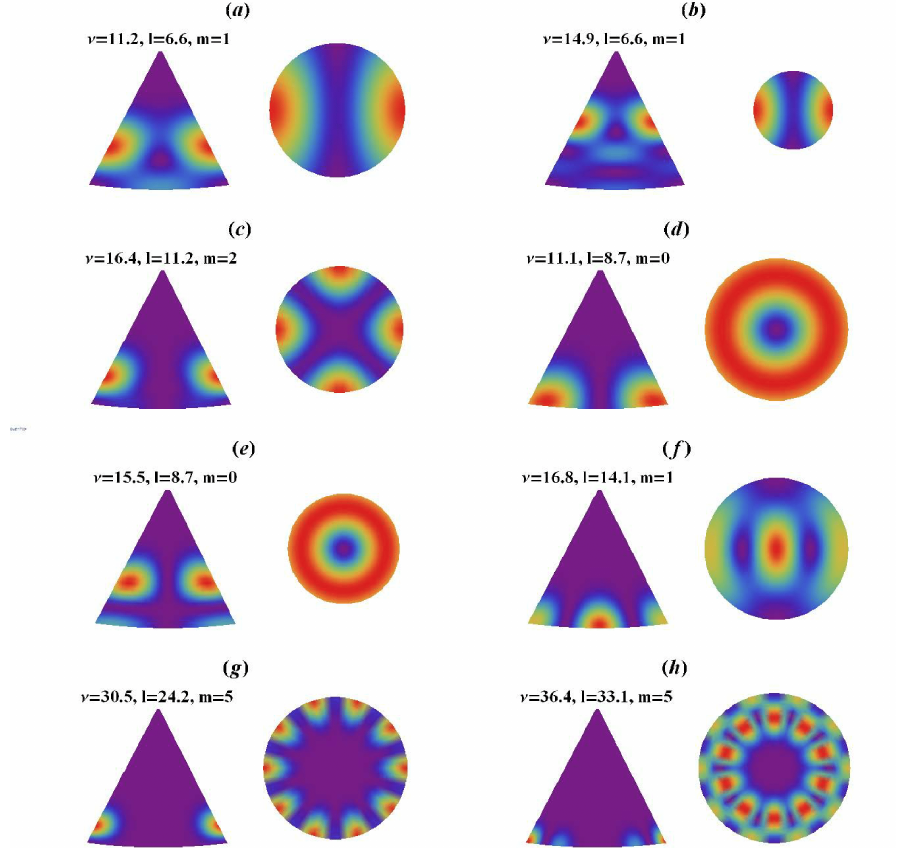
Figure 28. EM resonances spectrum for a conical resonator. The opening angle of cone is 30 ◦ , the refractive index is n = 4, and the height is h = 595nm. The red and blue lines correspond to frequencies of electric and magnetic resonances, respectively, reprinted with permission from [18], the Optical Society (OSA).